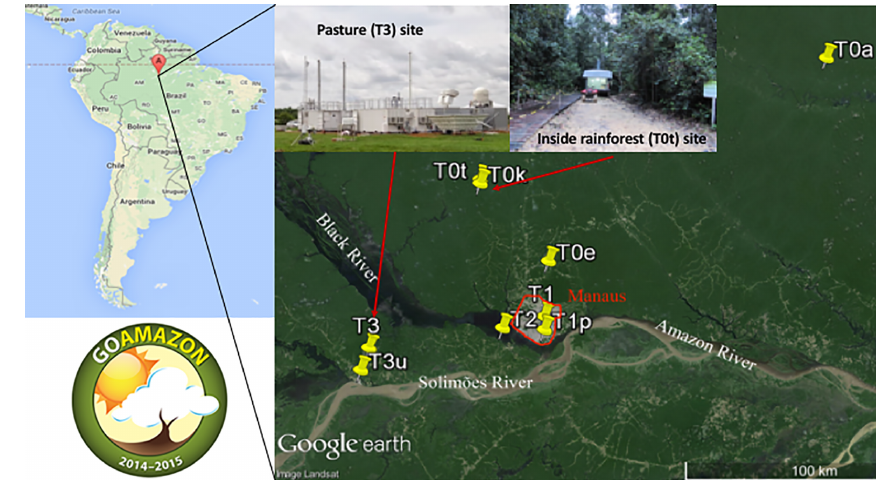
Figure 1. The location on the map and photos of the inside rainforest (T0t) and open pasture (T3) sampling sites in Amazonas are shown here. The left column shows a map of South America and the right-hand side shows a satellite view and photos of the T0t and T3